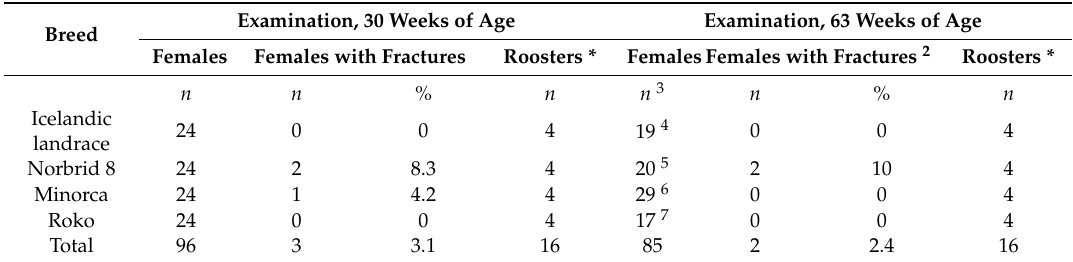
Table 2. Number of keel bone fractures depending on breed, sex and age ( n = 213 1